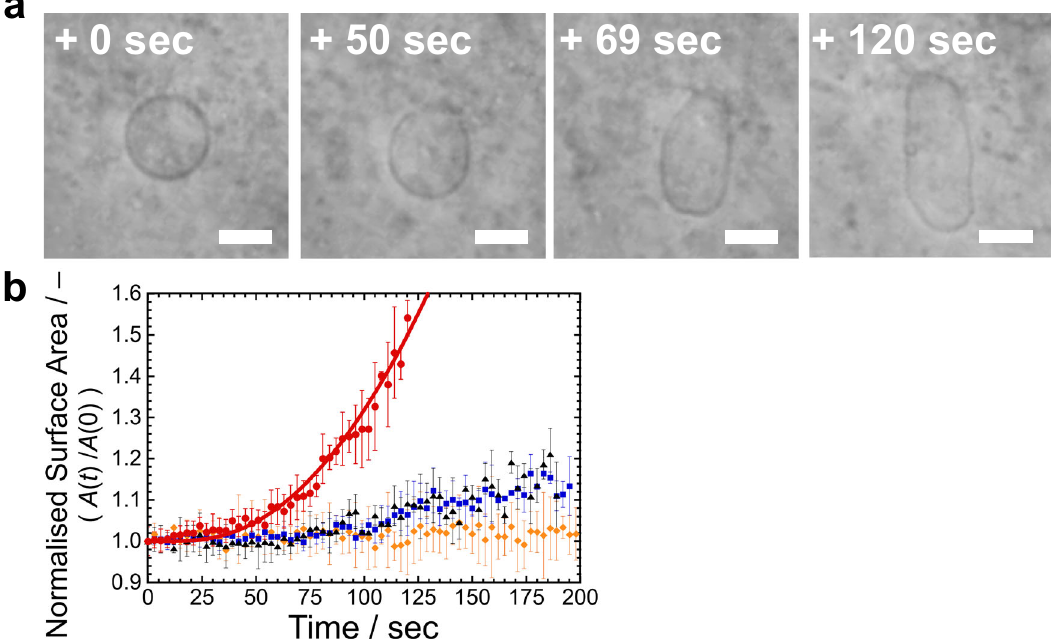
Fig. 3 Membrane growth of AOT GUVs promoted by PANI-ES on the vesicle surface. a Phase contrast light microscopy images of an AOT GUV during polymerisation of aniline under the optimised cascade reaction conditions combined with the micro-injection of 20 mM AOT micellar solution containing 100 mM D-glucose (see Methods ). The elapsed time after starting the micro-injection is indicated in each image. Length of the scale bar: 10 µ m. See also Supplementary Movie 1 . b Membrane growth of AOT GUVs in response to the micro-injection of AOT micelles under various polymerisation conditions. Red circles: Membrane growth of AOT GUVs under the optimised cascade reaction conditions. Red solid line: Theoretical prediction based on the kinetic model (model-1, see Supplementary Note 3-3(i)). Blue squares: D-glucose was not contained in the micro-injection solution (otherwise, the optimised cascade reaction conditions were applied), i.e ., lack of ingredients for H 2 O 2 production. Orange diamonds: Aniline, HRPC, and GOD were not contained in the AOT GUV suspension (otherwise, the optimised cascade reaction conditions were applied), i.e ., lack of enzymes for the production of H 2 O 2 and lack of monomer and enzyme for the polymerisation reaction to occur. Black triangles: D-glucose was not contained in the micro-injection solution, and aniline, HRPC, and GOD were not contained in the AOT GUV suspension (otherwise, the optimised cascade reaction conditions were applied), i.e ., only an AOT micellar solution was supplied to AOT GUVs in 20 mM NaH 2 PO 4 solution (pH = 4.3). The surface area of each GUV at time t ( A ( t )) was normalised by the initial value at t = 0 ( A (0)). The error bars indicate standard deviations estimated from four to six different